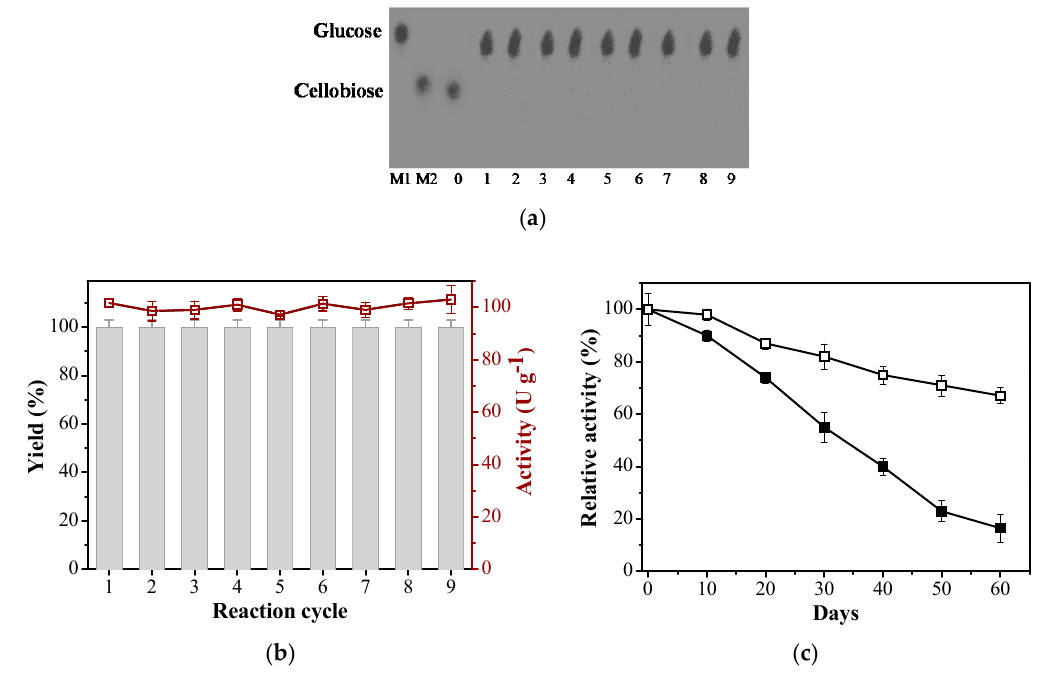
Figure 2. ( a ) Thin-layer chromatography of sugars produced from hydrolysis enzymatic in different recycle. M1: glucose, M2: cellobiose, lane 0, 1, 2, 3, 4, 5, 6, 7, 8, 9: cellobiose incubated with agarose-GLU-IDA-Co 2+ - Ea BglA-PEI (167 U g − 1 of support). ( b ) Reusability assay of agarose-GLU-IDA-Co 2+ - Ea BglA-PEI using cellobiose as substrate. Line (activity U g − 1 of support) and bars (yield %). ( c ) Storage stability of free and agarose-GLU-IDA-Co 2+ - Ea BglA-PEI (storage conditions: 4 °C, pH 7.0). Free Ea BglA (filled squares) and agarose-GLU-IDA-Co 2+ - Ea BglA-PEI (empty squares). The initial activities were regarded as 100% and relative activities were expressed as a percentage of initial